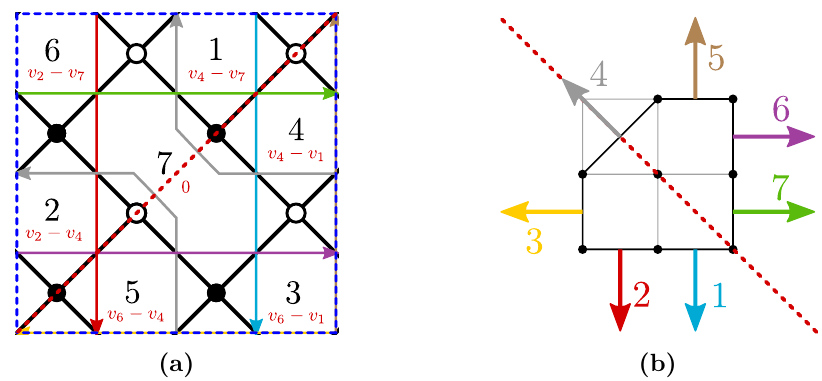
Figure 10. (a) Dimer diagram for PdP 4 with a diagonal fixed line (dotted red). We show the ZZPs and the rank assignments coming from them. (b) The toric/web diagram with the corresponding symmetry